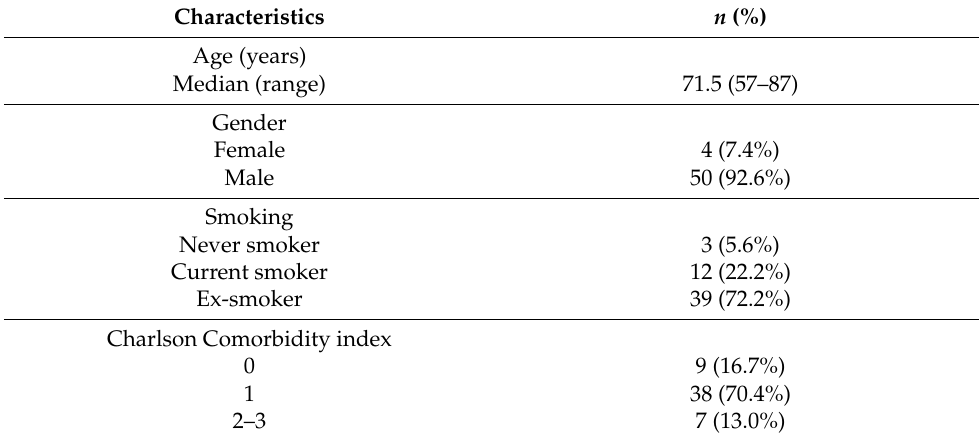
Table 1. Clinical